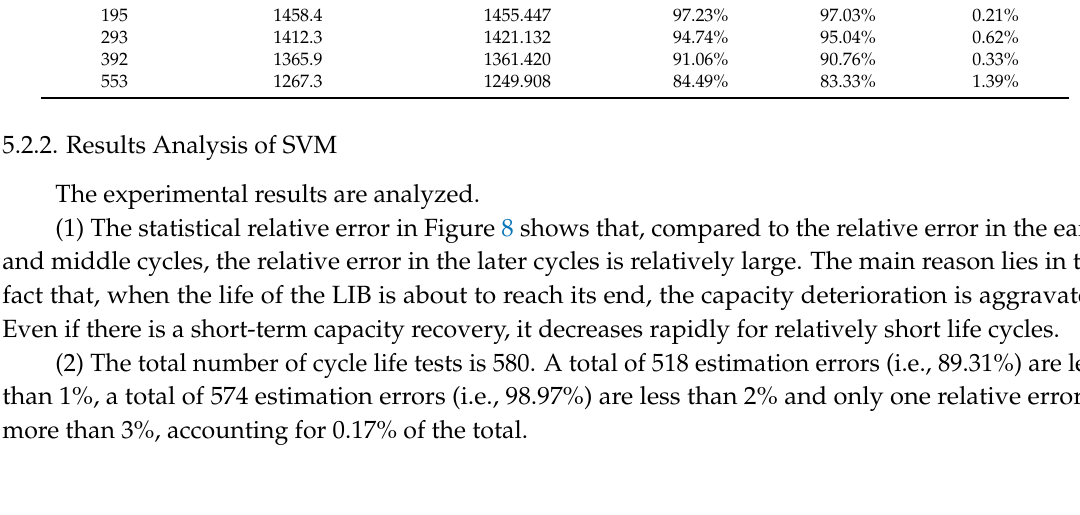
Table 5. Estimated error of No. 1 battery in test 2.